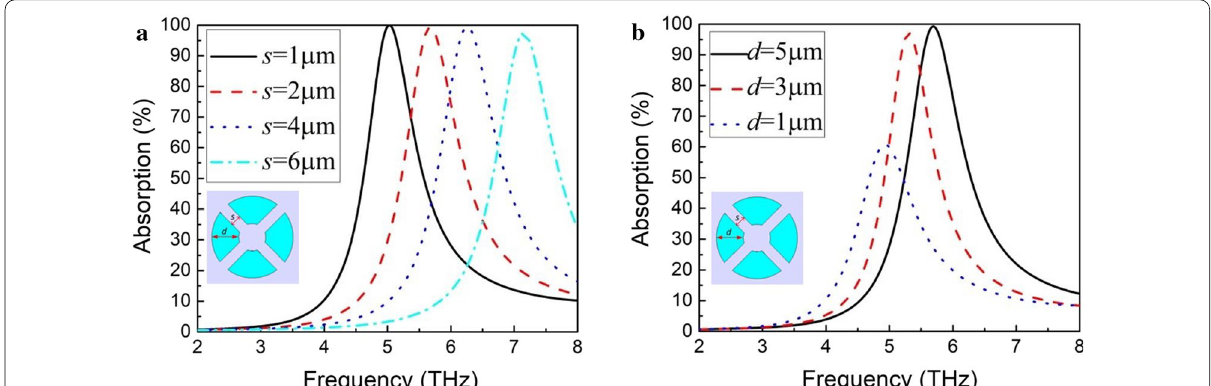
Fig. 2 a THz wave absorption of periodic split-ring structures with different opening widths ( s ). The split-rings have an outer radius of 15 μm, an inner radius of 10 μm and a thickness of 10 nm. b THz wave absorption of periodic split-ring structures with different ring widths ( d ). The split-rings have an outer radius of 15 μm, an opening width of 2 μm and a thickness of 10